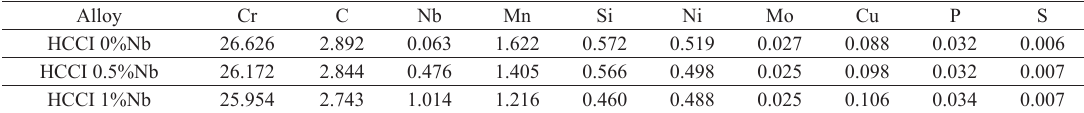
Table 1. Chemical compositions of alloys